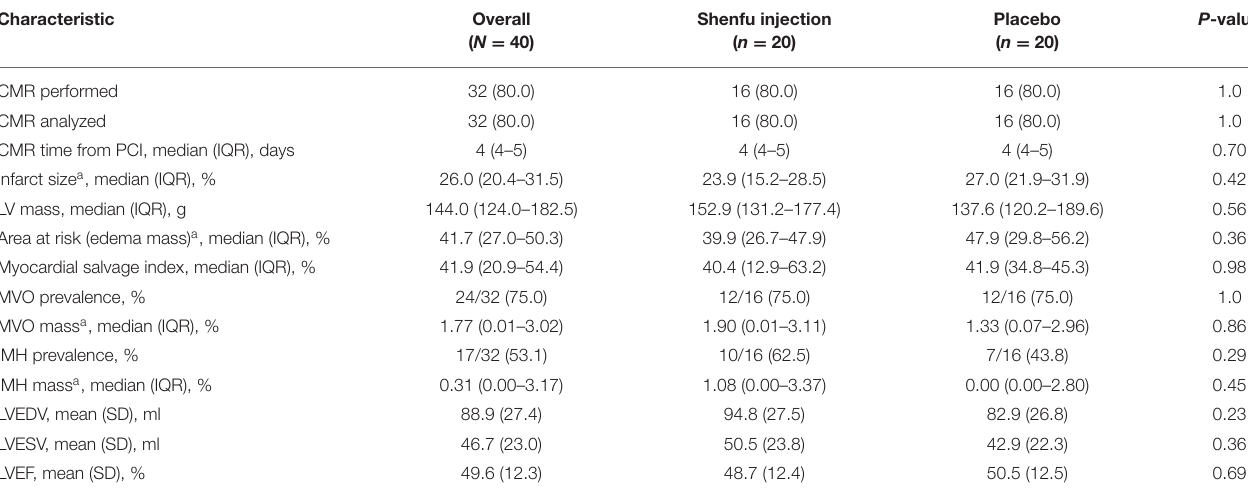
TABLE 2 | Cardiac magnetic resonance imaging analysis 4 + 1 days post percutaneous coronary intervention. Characteristic